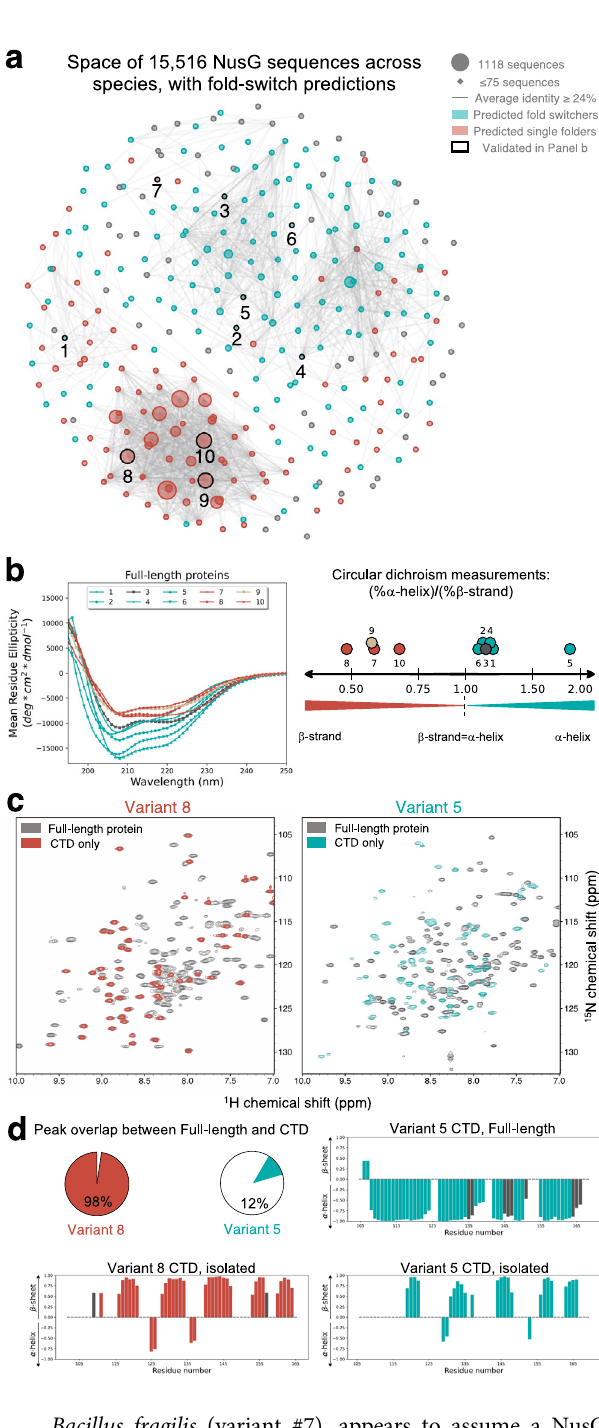
Fig. 2 RfaH/NusG sequence space. a Force-directed graph of 15,516 full- length RfaH/NusG sequences. The largest node contains 1118 sequences; all nodes with 75 sequences or fewer are the same (smallest) size. Edges connecting the graph represent an average aligned identity between the sequences in two nodes ≥ 24%. Nodes labeled in teal/red were predicted to be fold switchers/single folders, on average; gray nodes contained only sequences with low-con fi dence predictions. Nodes with successfully puri fi ed and characterized variants are outlined in black; nodes with all experimentally tested variants are shown in Fig. S3. b CD spectra of all full- length constructs cluster into RfaH-like (teal) and NusG-like spectra (red). Fractions of α -helix: β -sheet measured from these spectra are shown to their right. All ratios for predicted fold switchers are larger than 1.0; all ratios for predicted single folders are less than 0.75. Numerical labels shown in ( a ) correspond to variant numbers. Numbers are shown on a log 2 scale. E. coli RfaH (Variant #3) and E. coli NusG (Variant #9) references are colored gray and beige, respectively, in both panels. c The 1 H- 15 N HSQCs of full-length and CTD variants of a putative single-folder (Variant #8) are nearly superimposable, By contrast, the HSQCs of full-length and CTD variants of a putative fold switcher (Variant #5) differ signi fi cantly. d Percentages of HSQC overlap from ( c ) are quanti fi ed: 98% overlap for Variant 8 demonstrates that its CTD does not switch folds. Its isolated CTD was assigned and found to assume β -sheet secondary structure (bottom right). By contrast, 12% overlap for Variant 5 suggests that its CTD might switch folds. Its CTD was assigned by NMR in both full-length (top right) and isolated (bottom right) forms. Consistent with fold switching, its CTD in the full-length form was found to be α -helical, while its isolated CTD was found to be β -sheet. Colored bars are based on chemical shift assignments; gray non-zero bars show secondary structure predictions based on computational modeling only (Methods). Source data are provided as a Source Data fi